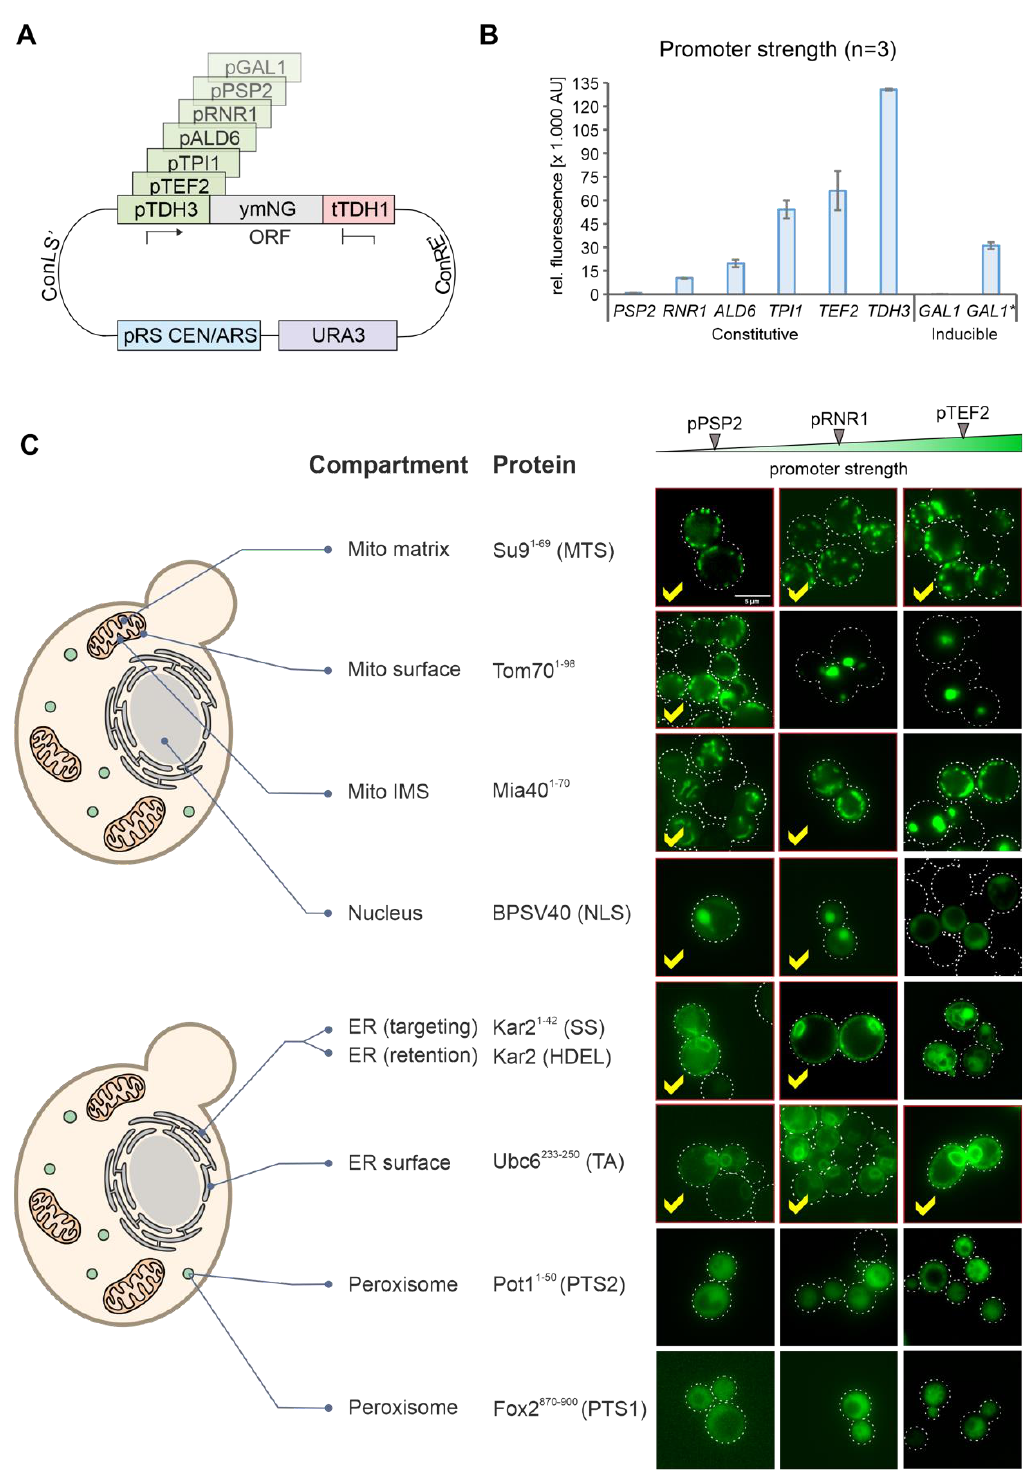
FIGURE 4: Correct intracellular localization depends on the promoter strength used for expression of the fusion proteins. (A) Schematic representation of the plasmid showing the different MoClo cassettes. The different promoters used are indicated in green. (B) Wild type (YPH499) cells with the different expression plasmids were grown to mid log phase in synthetic glucose medium. For the asterisk-labeled GAL1 sample, cells were grown on lactate-containing medium to mid-log phase; then 0.5% galactose was added, and cells were further grown for 4h. Cells were harvested, and the fluorescence intensity of the NeonGreen protein was measured by fluorescence spectroscopy in a plate reader. For each biological replicate (N = 3) technical triplicates were measured. Shown are the mean values from all three independent measurements, error bars represent the standard deviation. (C) Representative fluorescence images showing the distribution of NeonGreen in the different strains indicated. Samples in which the protein distribution showed the correct intracellular compartments were labeled by red frames and check marks. Scale bar, 5